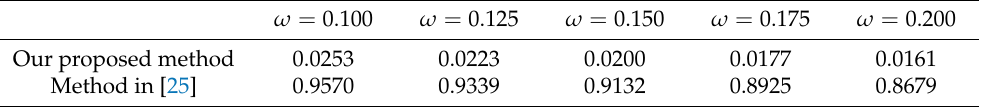
Table 1. Error rate of two control schemes. ω = 0.100 ω = 0.125 ω = 0.150 ω = 0.175 ω =